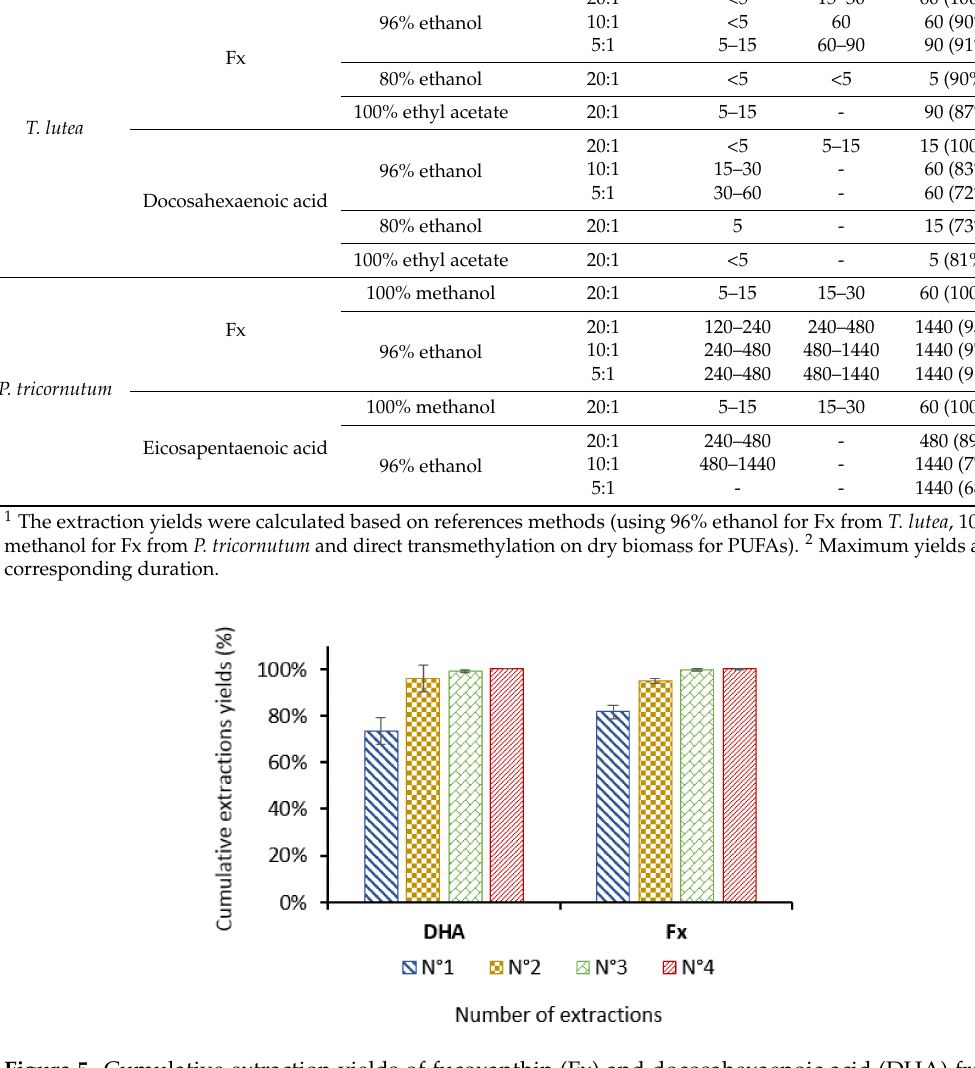
Figure 5. Cumulative extraction yields of fucoxanthin (Fx) and docosahexaenoic acid (DHA) from freeze-dried Tisochrysis lutea biomass with four successive 1 h extractions on the same biomass with a 10:1 ( v / w ) ethanol/biomass ratio ( n = 3